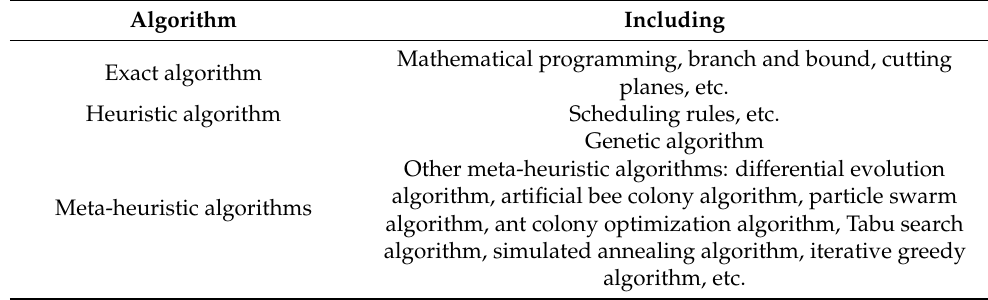
Table 2. Algorithm for optimization of production scheduling for forging